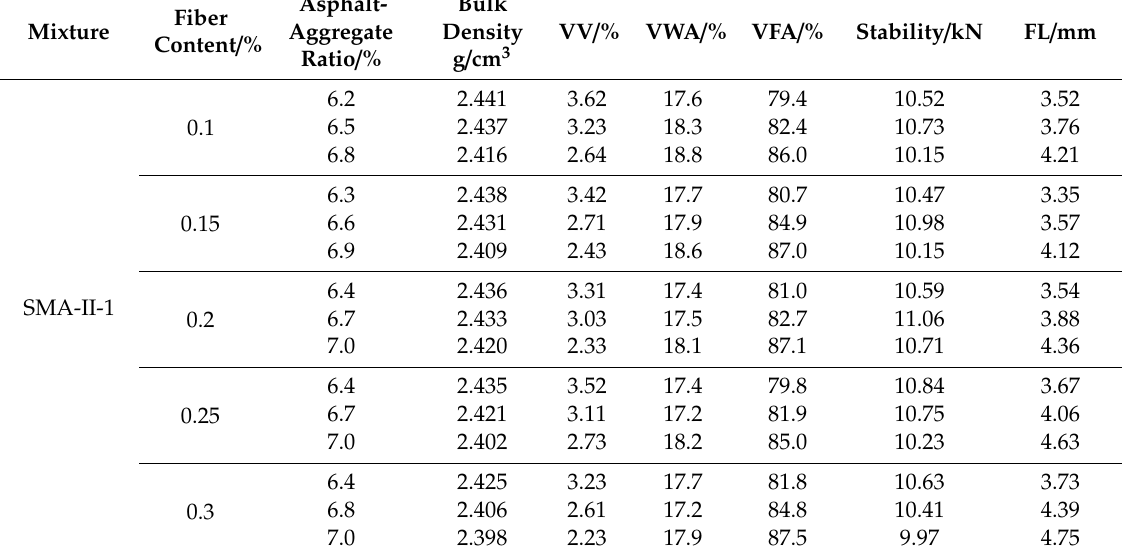
Table 9. Basic parameters and Marshall volumetric indicators of the mixture.